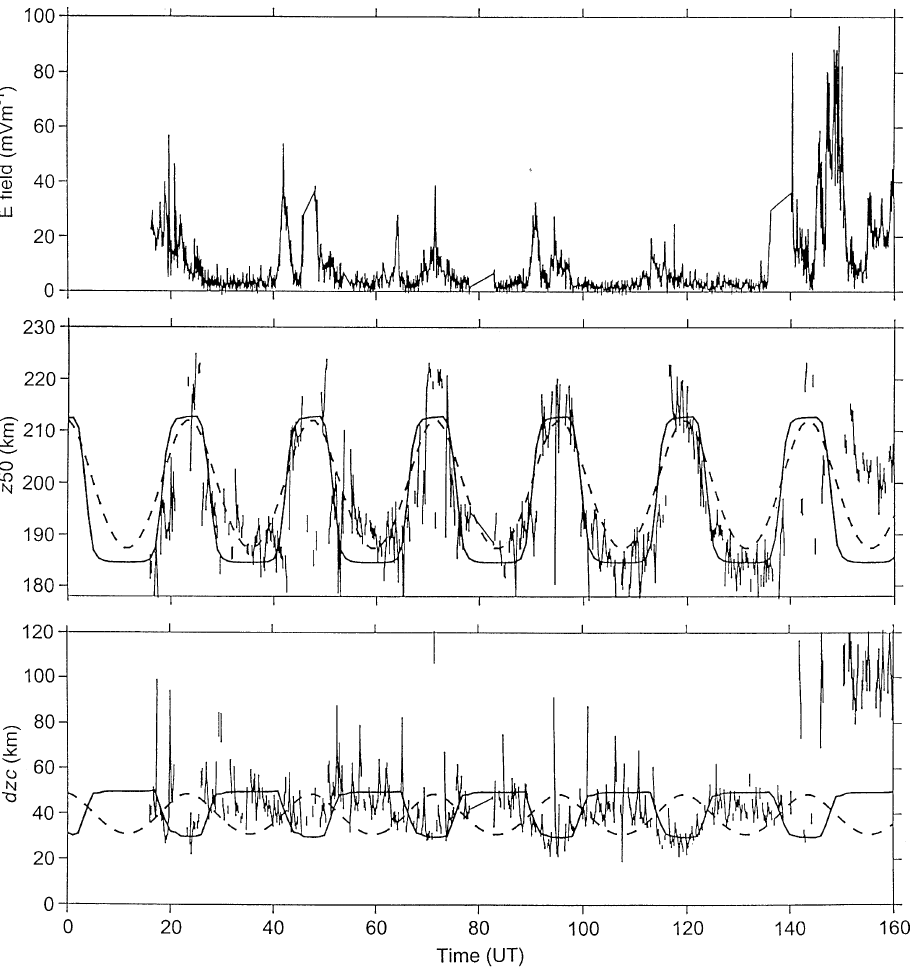
Fig. 3. Transition altitude and transition width of the composition profile derived from the MLTCS